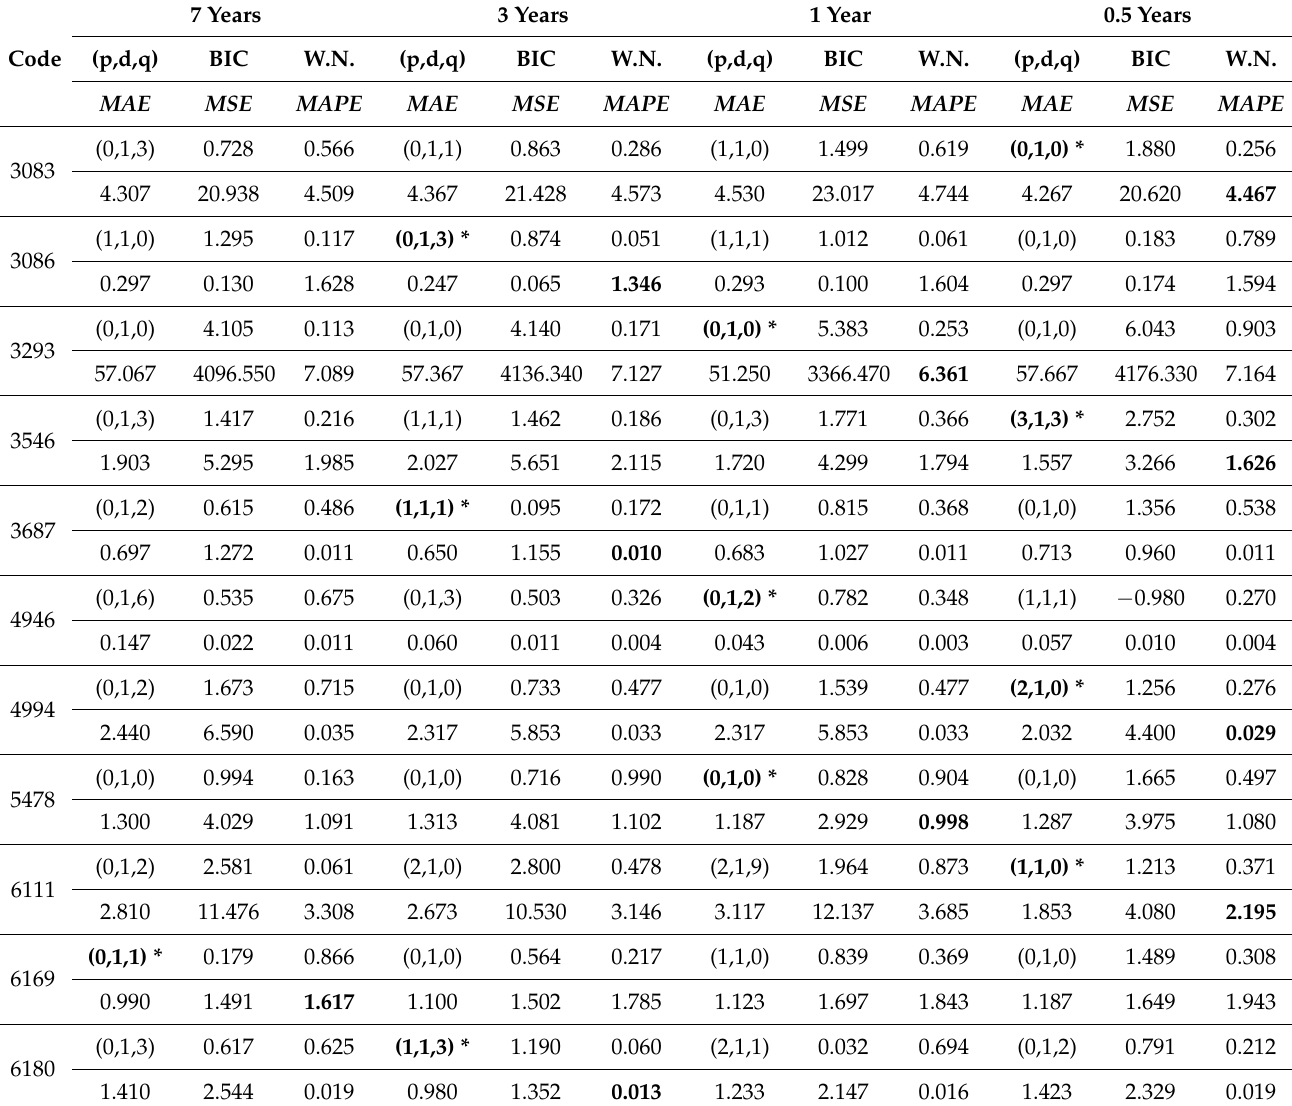
Table 6. Comparison of the optimal ARIMA models in different data